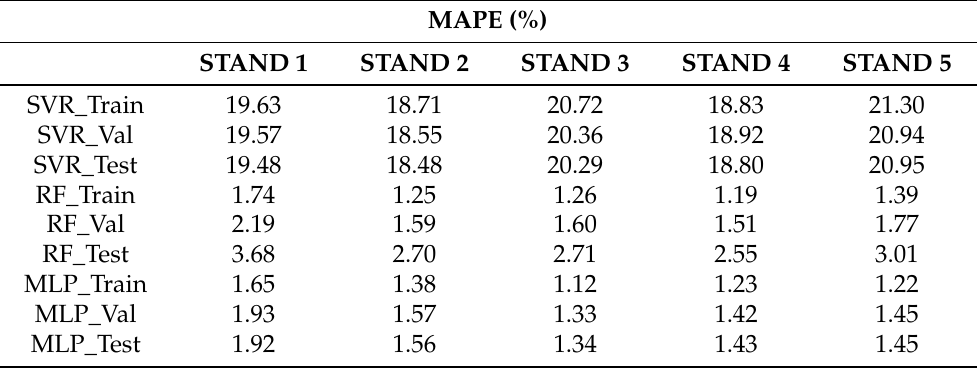
Table 18. Comparison with a baseline of machine learning methodologies for motor load prediction using MAPE.